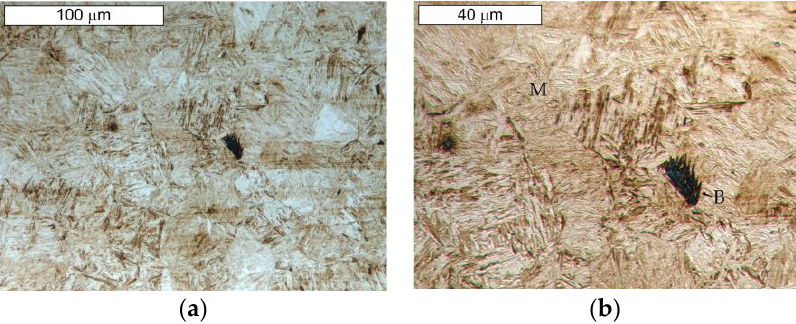
Figure 13. View of ( a ) the microstructure of steel Hardox and ( b ) a magnified fragment of the area in Figure 13a (M — martensite, B — bainite). Light microscopy, etched.